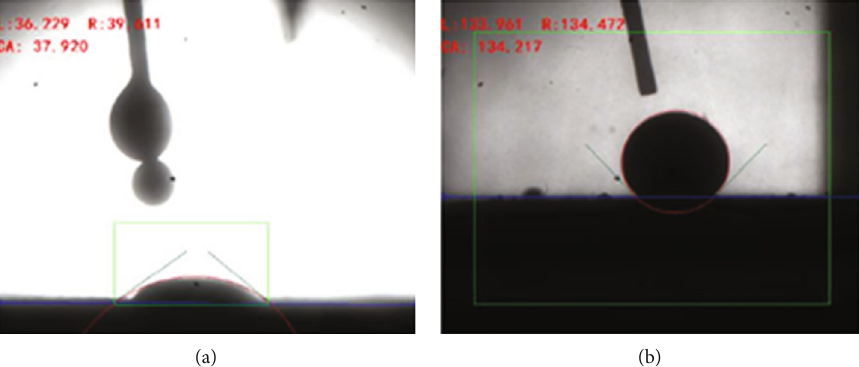
Figure 6: The wetting angle (a) preadding imbibition agent and (b) postadding imbibition